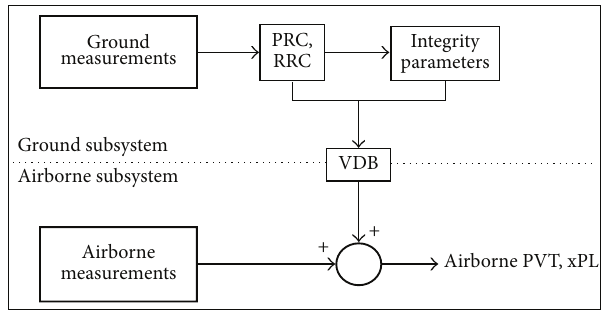
Figure 1: Simple overview diagram of GBAS